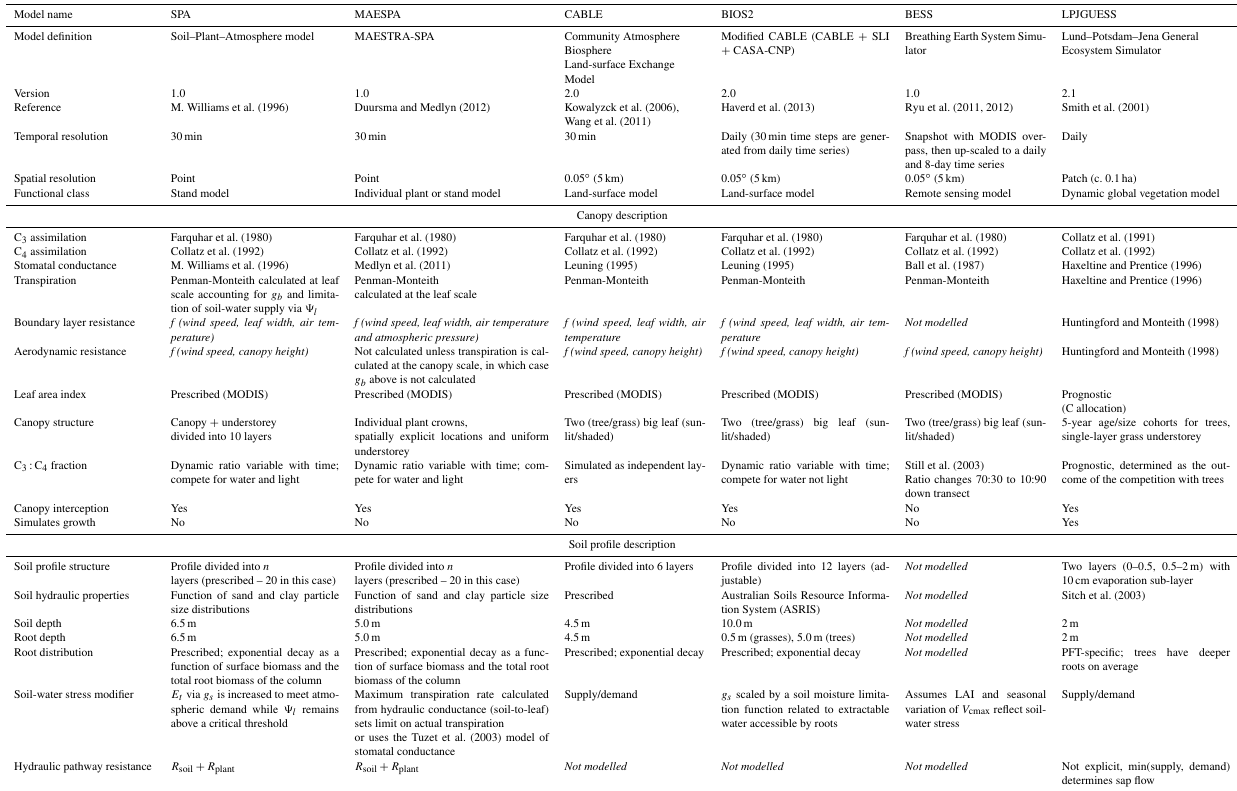
Table 2. Summary table of the ecosystem models used in the experiment, highlighting differences and similarities in model structure and shared processes. Information is broken down into how each model describes aboveground canopy and belowground soil